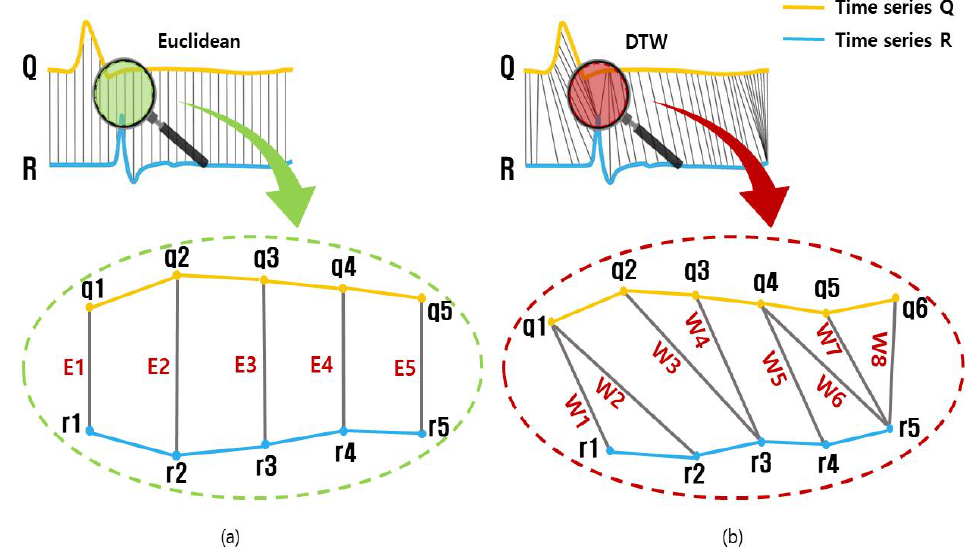
Figure 3. Aligning rules for the ( a ) Euclidean (E) algorithm and ( b ) Dynamic Time Warping (DTW) algorithm. ‘E’ and ‘W’: lines showing mapping between two points that each methodology compares.